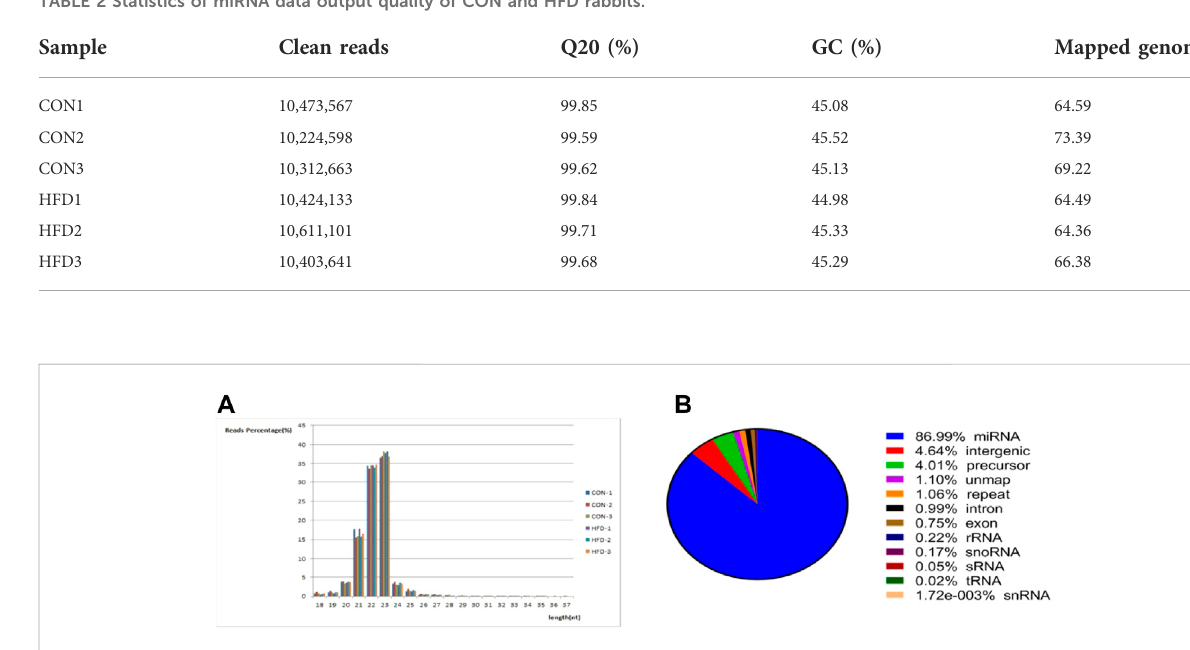
TABLE 2 Statistics of miRNA data output quality of CON and HFD